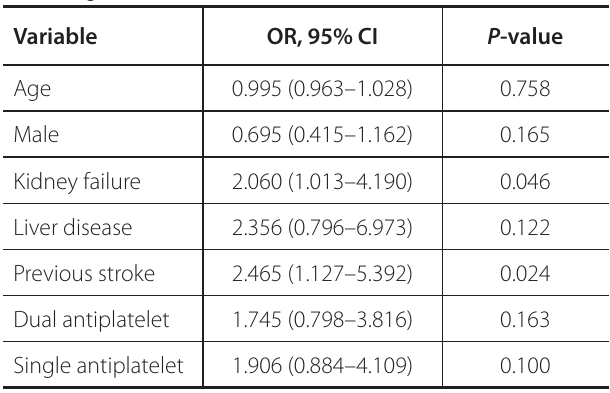
Table 3 . Multivariable analysis of predictors of